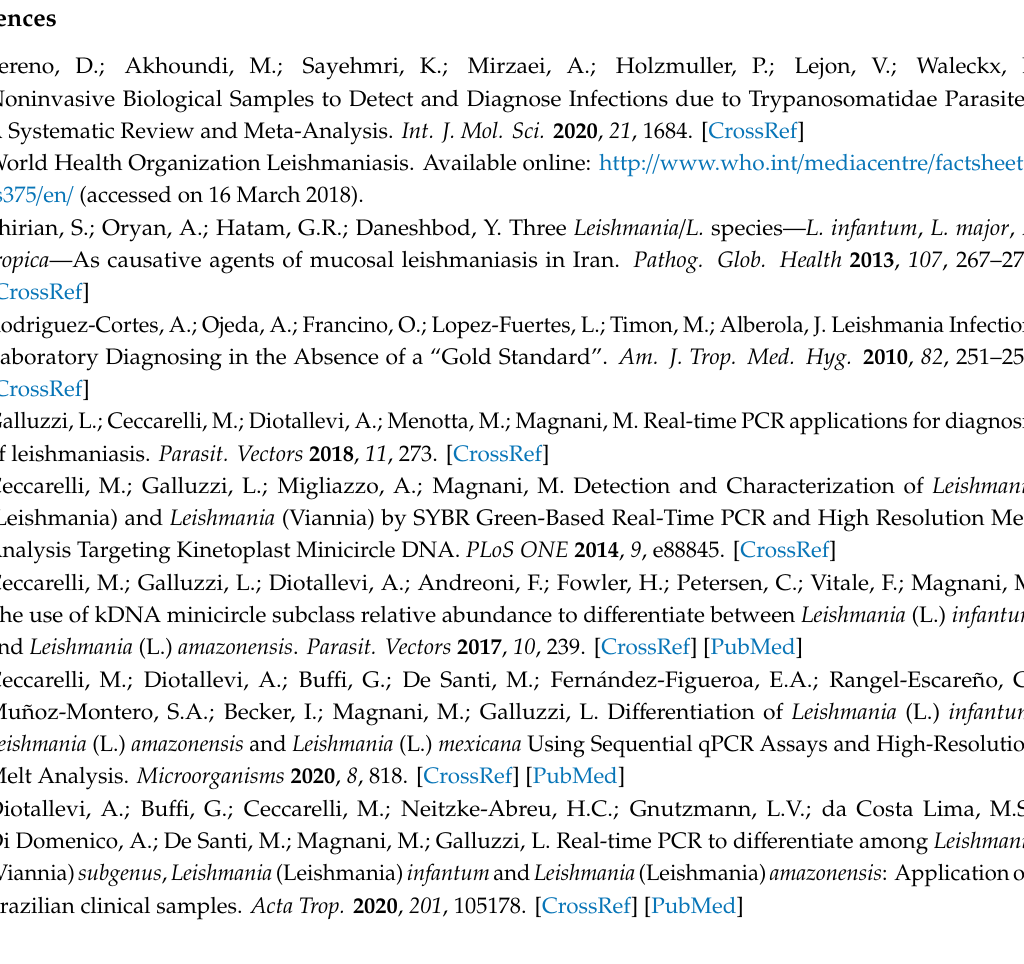
Figure S1: Maximum likelihood phylogenetic tree of qPCR-ML